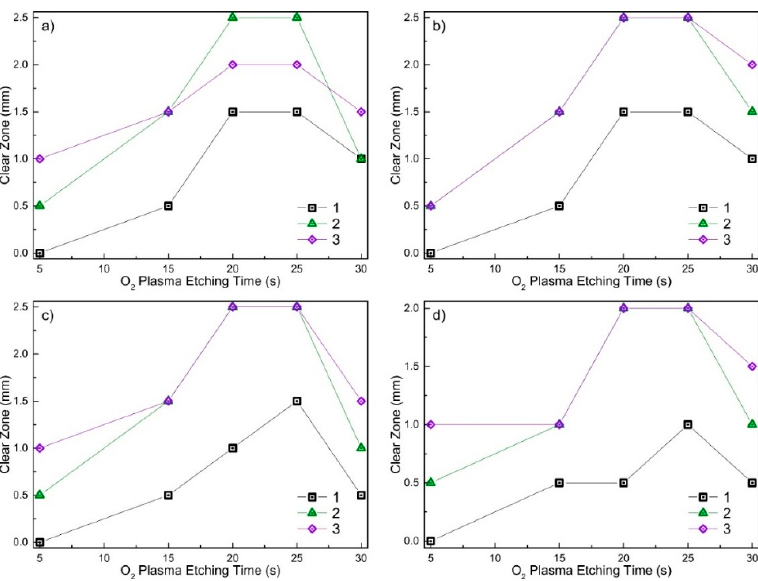
Figure 3. Antimicrobial effect (linear dimensions of the clear zone) for three different Ag concentration DLC:Ag films deposited on silicon and processed with O 2 plasma for different durations (5–30 s) (Samples 1–3) were tested with four different S. aureus bacteria strains, ( a ) LTSaDA01; ( b ) LTSaM01; ( c ) LTSa635 and ( d ) LTSa603, the employing disk diffusion method. Measurement uncertainty: 0.5 mm.